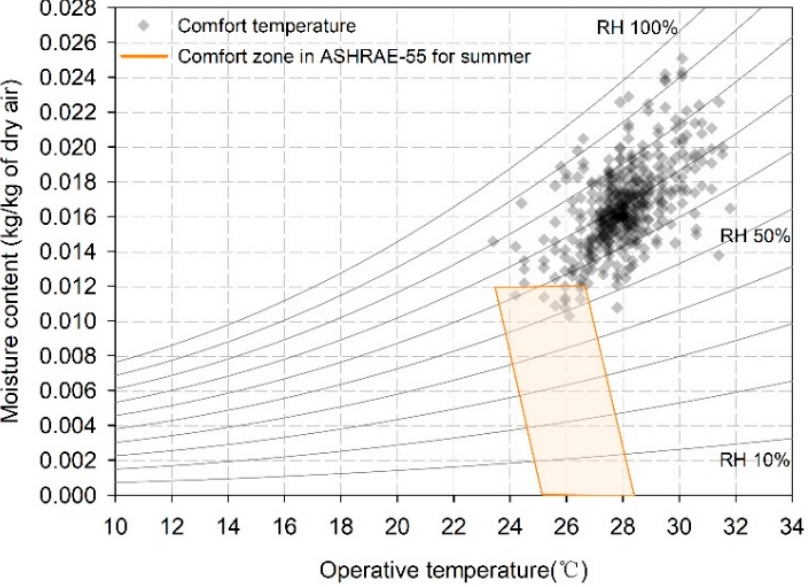
Figure 14. Comparison of comfort temperatures (this study) with recommended the comfort zone in ASHRAE-55 (PMV model) for summer.